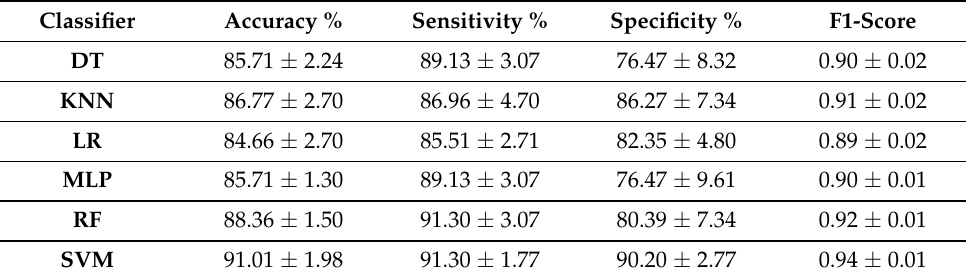
Table 5. The evaluation metrics (reported in mean ± standard deviation after 10 repetitions) of different ML classifiers using stratified 4-fold cross-validation approach, along with the integrated group of extracted